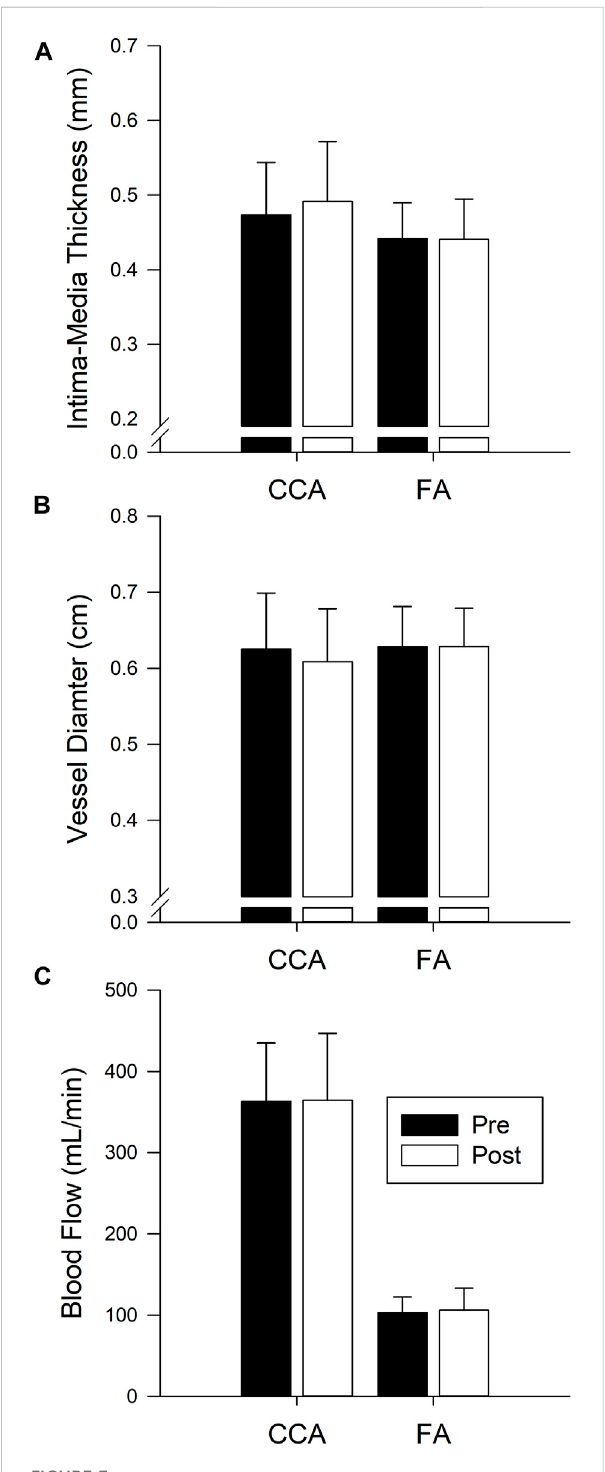
FIGURE 3 Barsrepresent themean± SDof intima-mediathickness (A) CCA n = 14, FA n = 10), diameter (B) CCA n = 12, FA n = 14), and blood fl ow (C) CCA n = 12, FA n = 14) for the common carotid artery (CCA) and femoral artery (FA) before (Pre, black bars) and after (Post, white bars) 40 days of isolation. No signi fi cant difference pre post.